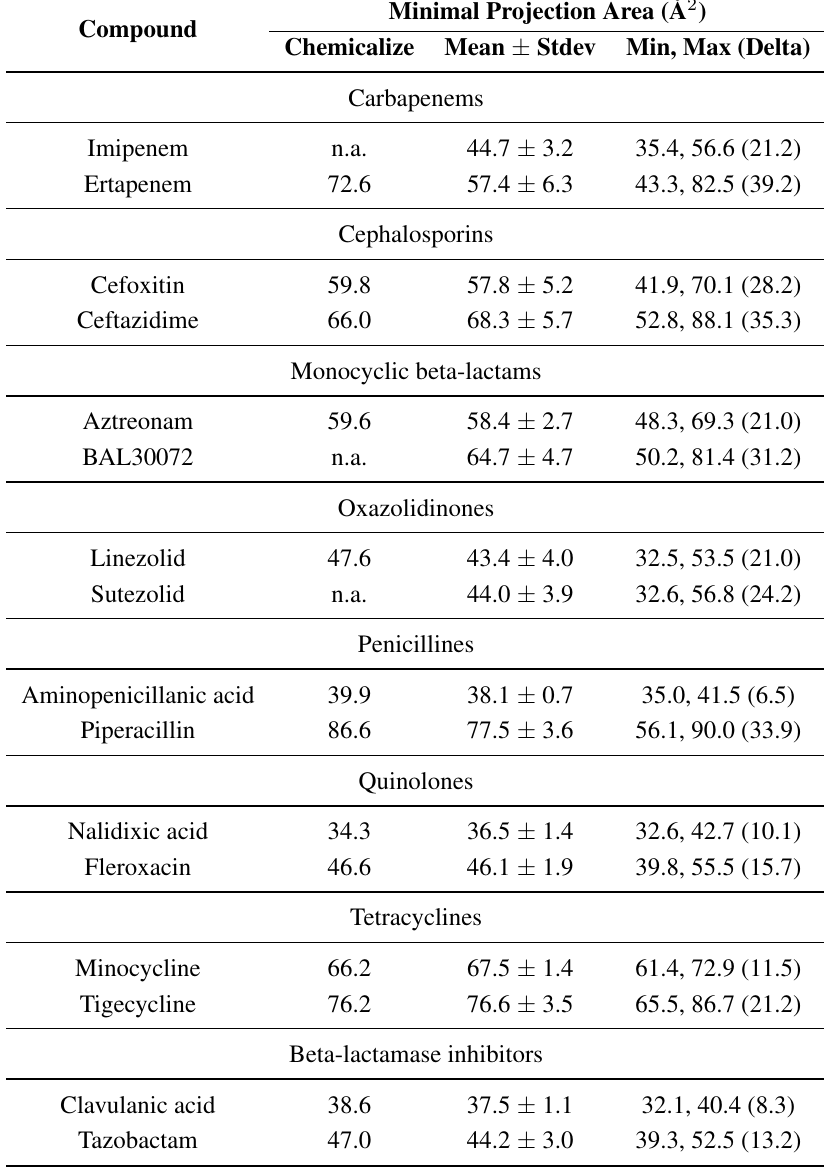
Table 1. Comparison between minimal projection areas taken from Chemicalize [98] and the average values and range of variability extracted from MD runs for selected